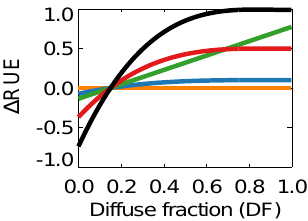
Figure 1. Relationship between DF and (cid:49) RUE for various assump- tions: max (cid:49) RUE = 0% (orange), 10% (blue), 50% (red), and 100% (black) from Greenwald et al. (2006), and linear (green) from Rochette et al.